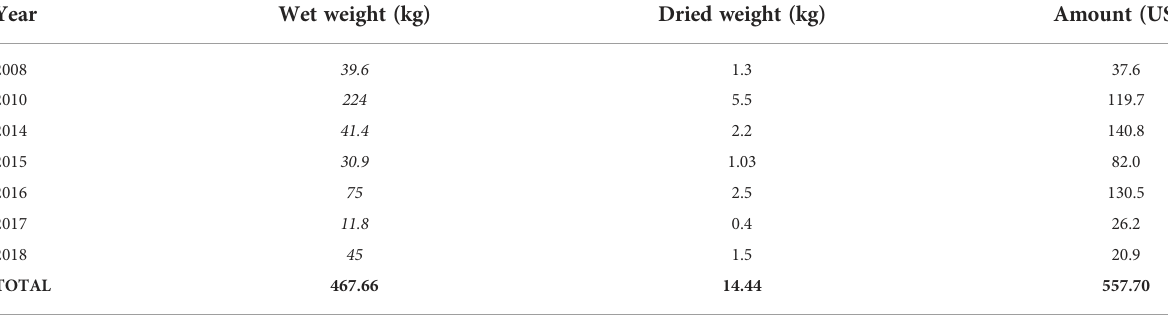
Wet weight values in italics indicate derived values from dried weight using 0.03 correction